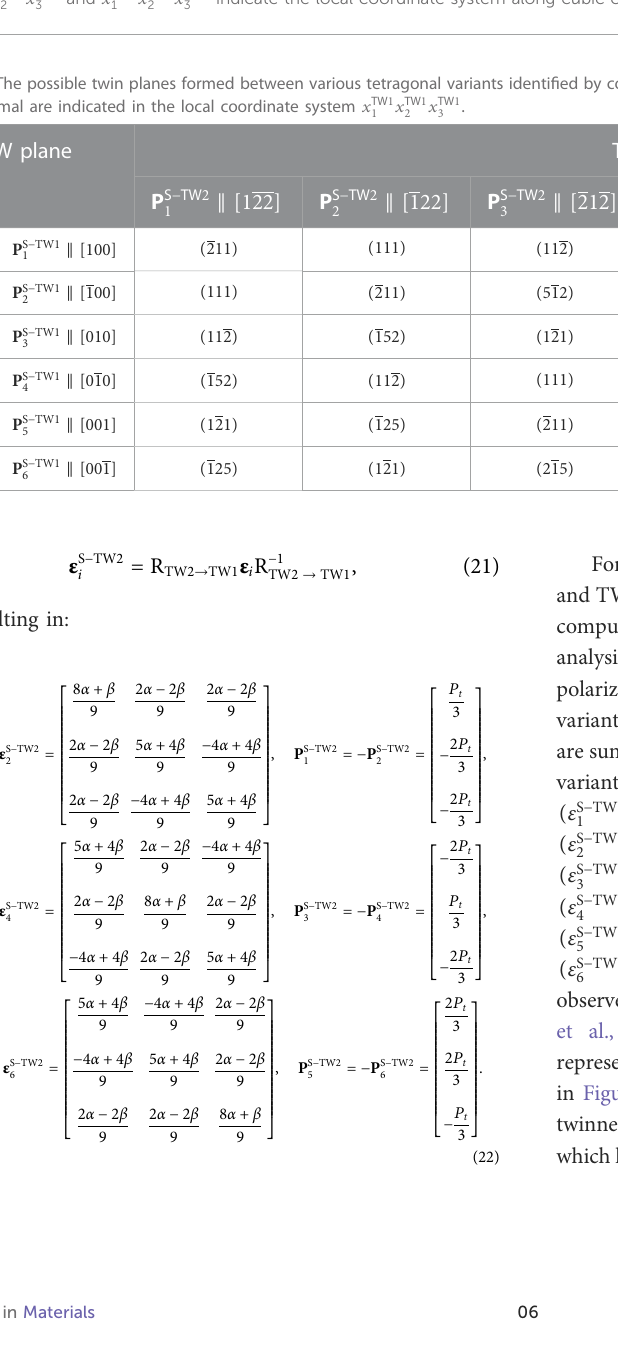
FIGURE 3 Schematics of the possible (111)-twins in tetragonal ferroelectrics; (A) Tetragonal ferroelectric variants ( ε S − TW1 5 indicate the local coordinate system along cubic crystallographic axes of TW1 and TW2, respectively.